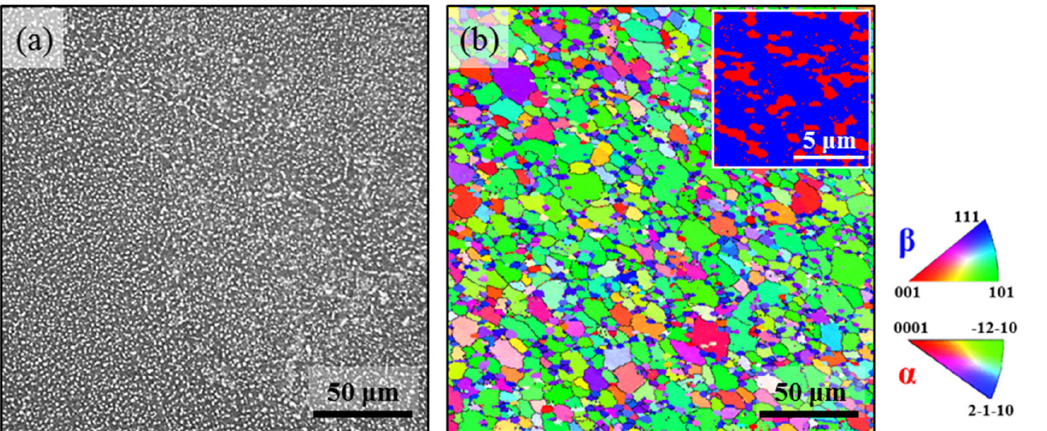
Figure 1. The microstructure of solution-treated Ti-45551 alloy: ( a ) SEM micrograph; ( b ) EBSD IPF map and phase map.